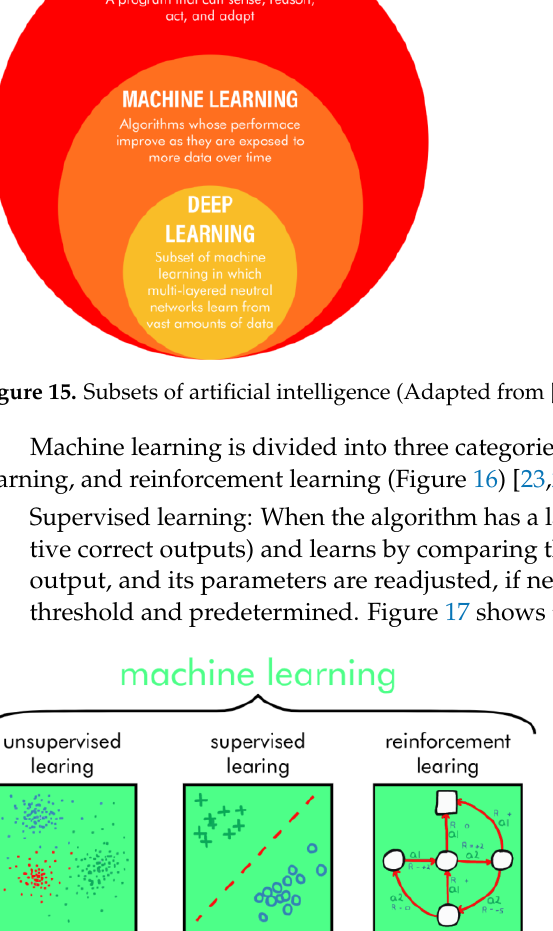
Figure 16. Machine learning categories (Adapted from [23,24]).